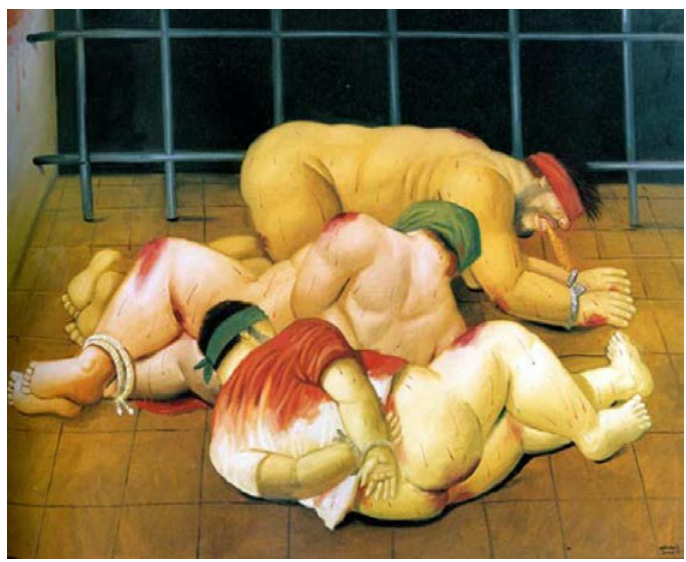
Figure 11 Fernando Botero, Abu Ghrib;2005 , oil on canvas , member of